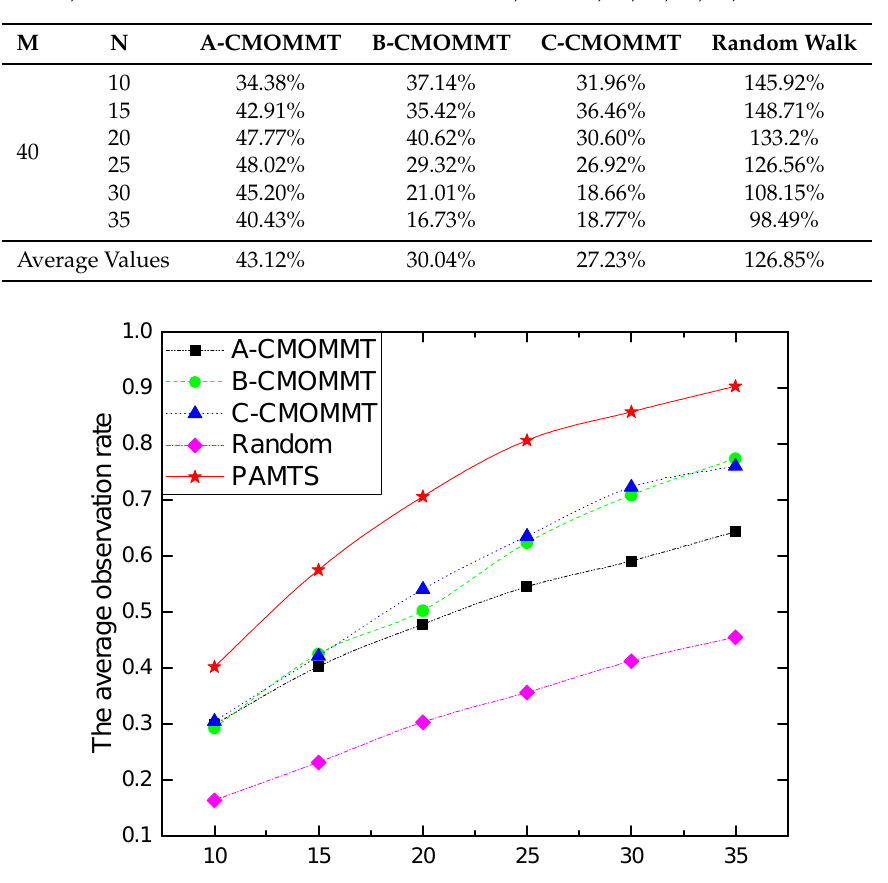
Figure 5. The impact of the various number of UAVs deployed in the search mission while that of targets is fixed to 40.